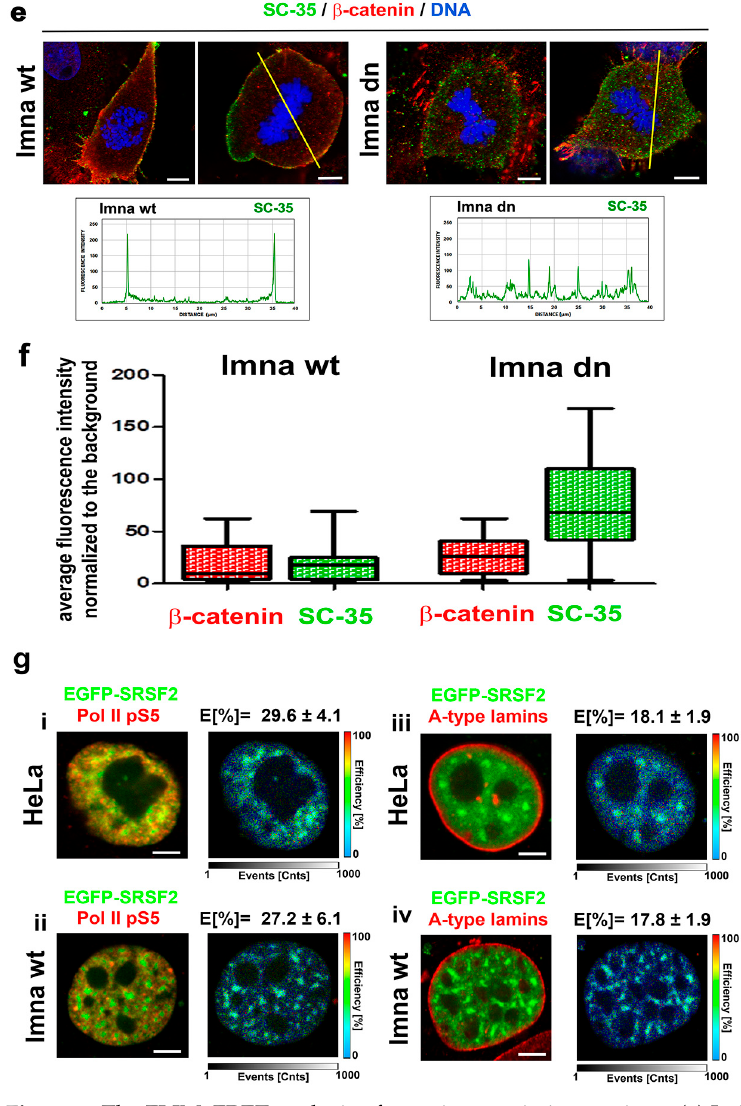
Figure 9. The FLIM–FRET analysis of protein-protein interactions. ( a ) In interphase lmna wt cells, the SC-35 protein interacts with the phosphorylated form of RNAP II (FRET efficiency 75.0% ± 2.7%). ( b ) The depletion of A-type lamins weakened the interaction of SC-35 and RNAP II; FRET efficiency was 23.2 ± 5.2%). ( c ) The SC-35 protein and β -catenin